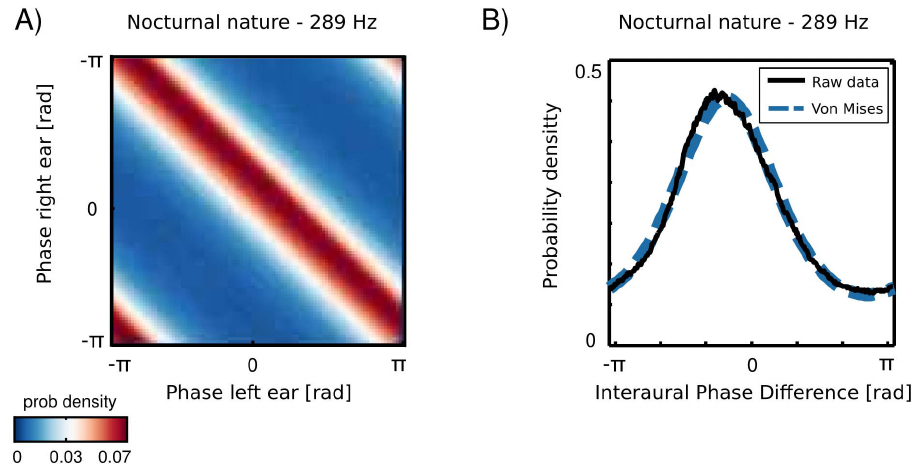
Figure 5. Binaural phase statistics . A) An exemplary joint probability distribution of monaural phases at 289 Hz. Data were taken from the nocturnal nature scene. B) An empirical IPD distribution of the same data (black line) plotted with a fitted von-Mises distribution (blue dashed line).